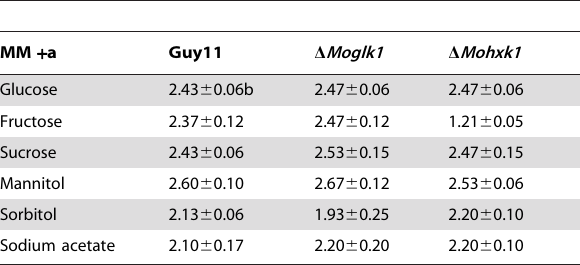
Table 1. Growth of D Moglk1 and D Mohxk1 mutants on different carbon